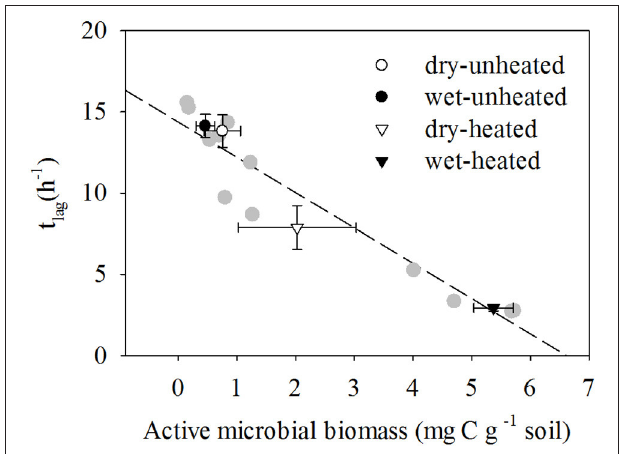
FIGURE 4 | The relationship between t lag and active microbial biomass at different temperature and soil moisture conditions (means ± SE shown in black and white symbols; n = 12). SM, Soil moisture. Individual replicates shown in gray, and two replicate observations at 33 ◦ C and 20% SM overlap.